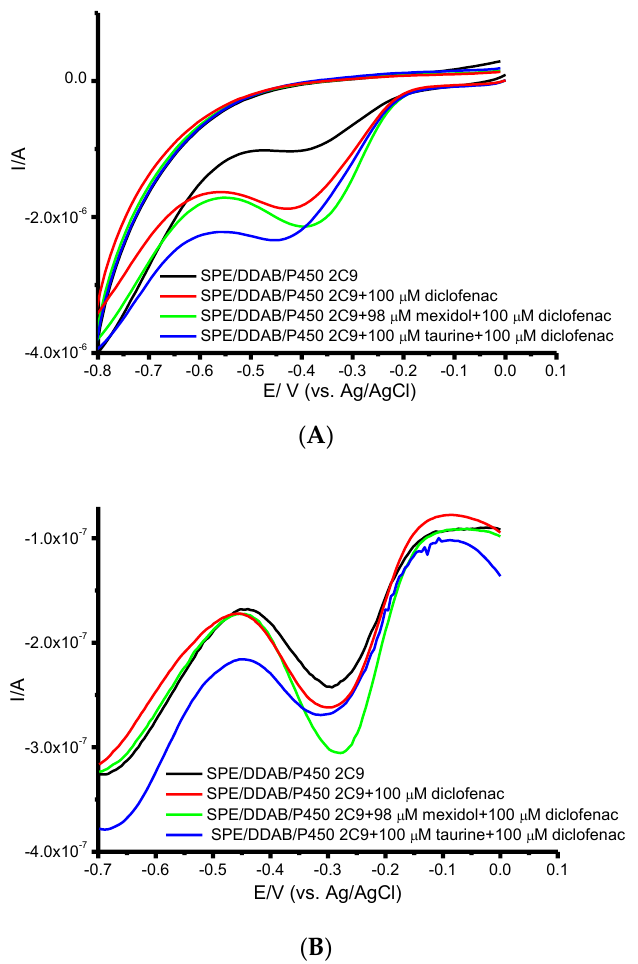
Figure 5. ( A ) Cyclic voltammograms of SPE/DDAB/P450 2C9 (- ), in the presence of 100 µM diclofenac (- ), in the presence of 98 µM mexidol and 100 µM diclofenac ( - ), in the presence of 100 µM taurine and 100 µM diclofenac (-), at a scan rate of 100 mV/s. ( B ) DPV of SPE/DDAB/P450 2C9 (-), in the presence of 100 µM diclofenac ( - ), in the presence of 98 µM mexidol and 100 µM diclofenac ( -), in the presence of 100 µM taurine and 100 µM diclofenac ( -).